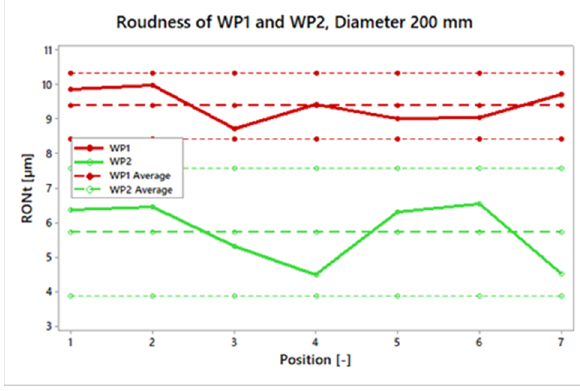
Figure 13. 300 mm outer diameter for TH1 and TH2 in position 04.